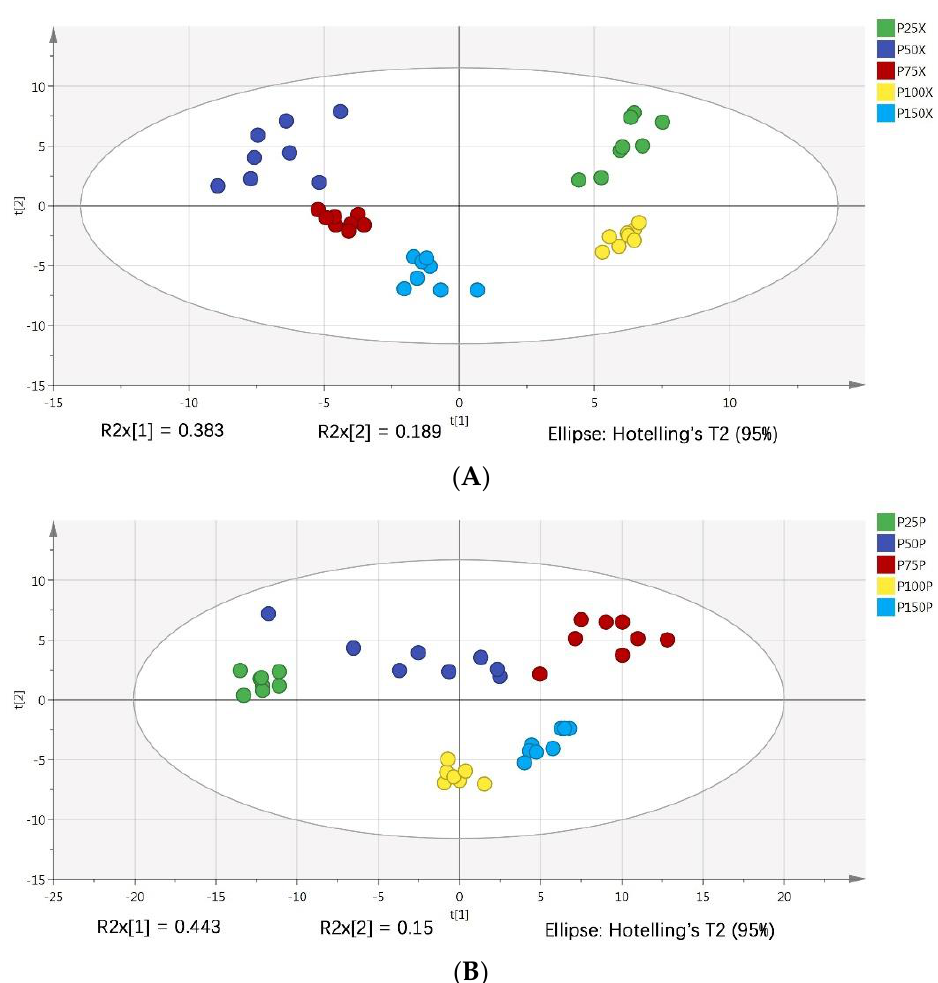
Figure 1. The PCA score maps of xylem ( A ) and phloem ( B ) sap.